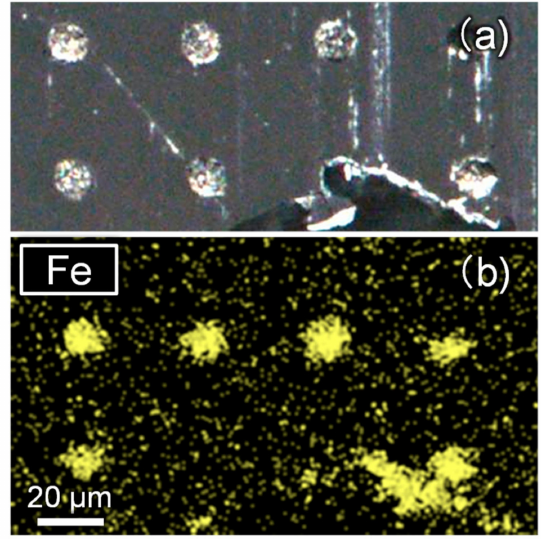
Figure 16. Surface images of silica glass die with textured dimple with 10 µ m in diameter after bending with ironing processes, ( a ) optical microscopic image, ( b ) EDX (energy dispersive X-ray) mapping of Fe